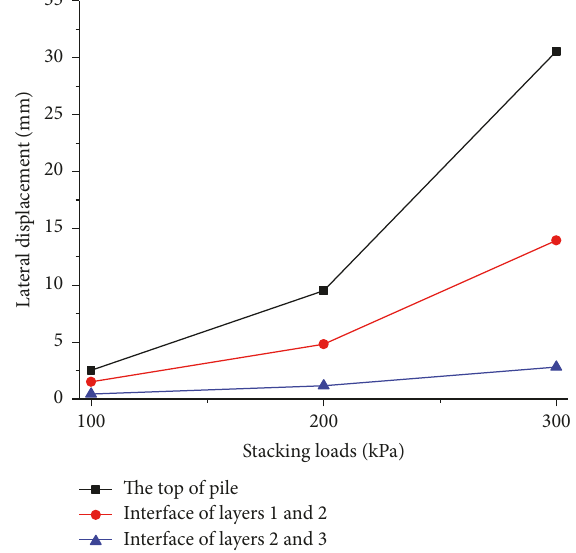
Figure 14: Relationship between lateral displacement and 𝐸 1 /𝐸 2 at different positions.